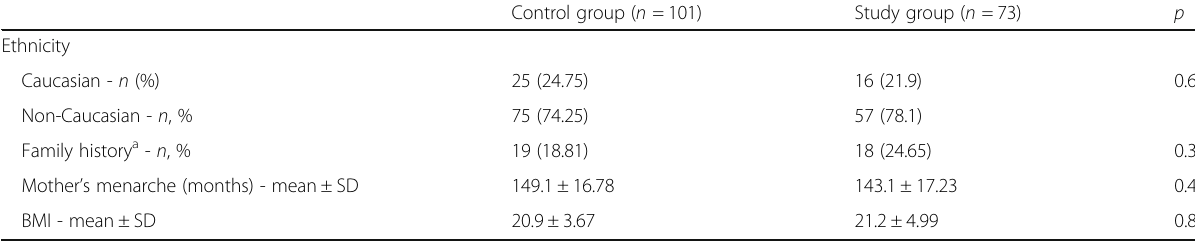
Table 2 Mean, standard deviation, and frequency distribution (%) of the participants ’ characteristics Control group ( n = 101) Study group ( n =